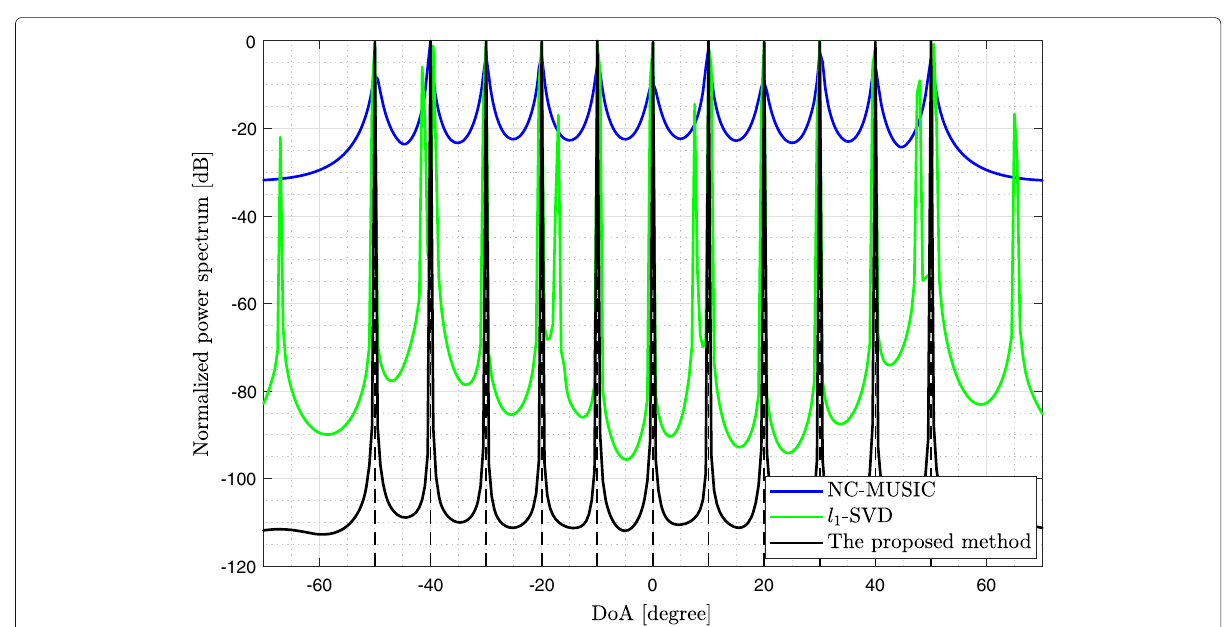
Fig. 2 Spatial spectral for NC-MUSIC, NC- l 2,1 -SVD, and the proposed algorithm